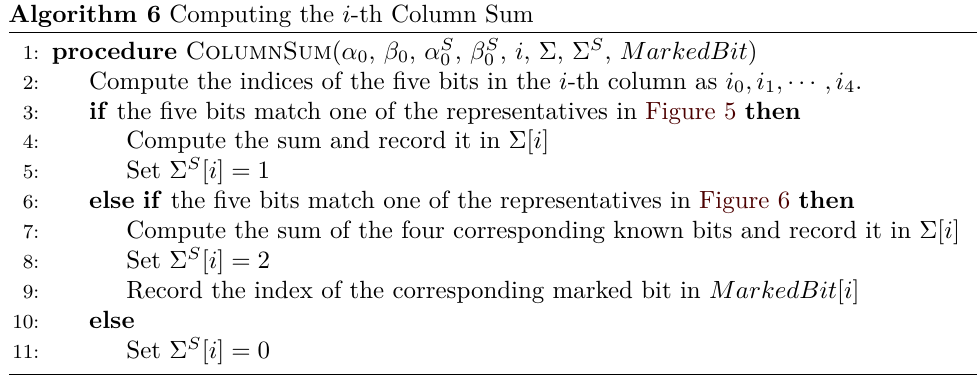
Algorithm 6 Computing the i -th Column